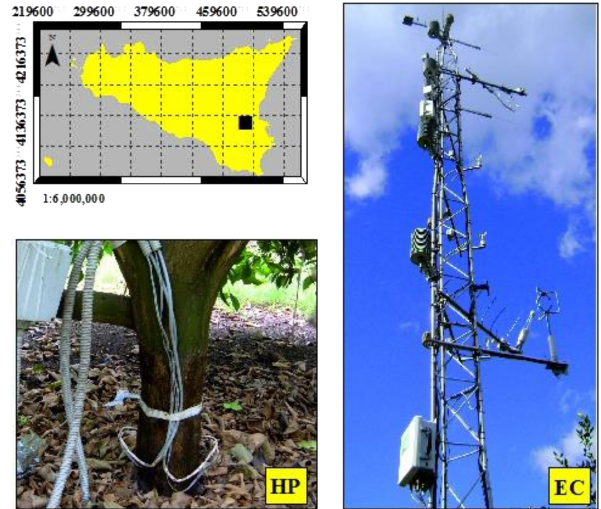
Figure 1. Bulgherano experimental site: the eddy covariance (EC) tower and a heat-pulse (HP) sap flow installation on an orange